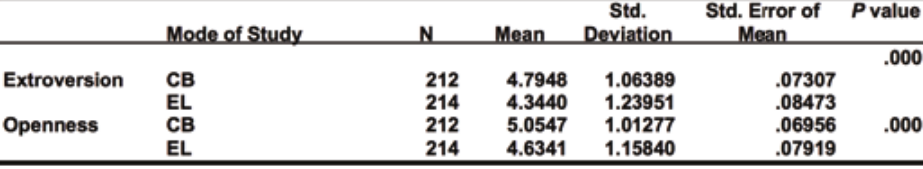
Table 8: Comparison of Extroversion and Openness to Experience between the Groups